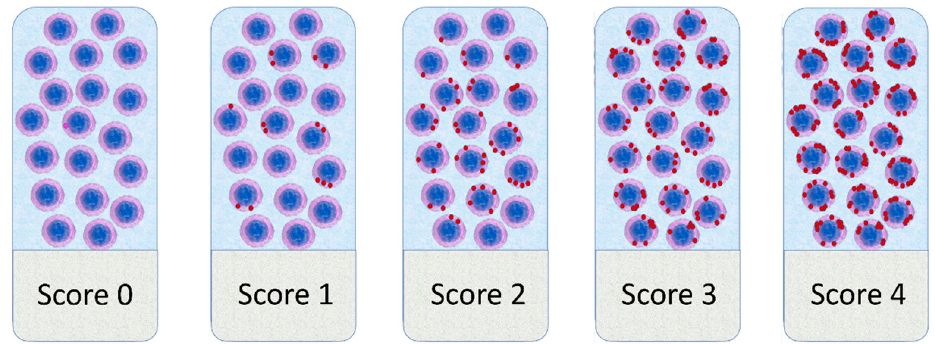
Figure 1. Graphical representation of the scoring system adopted for RNAscope results